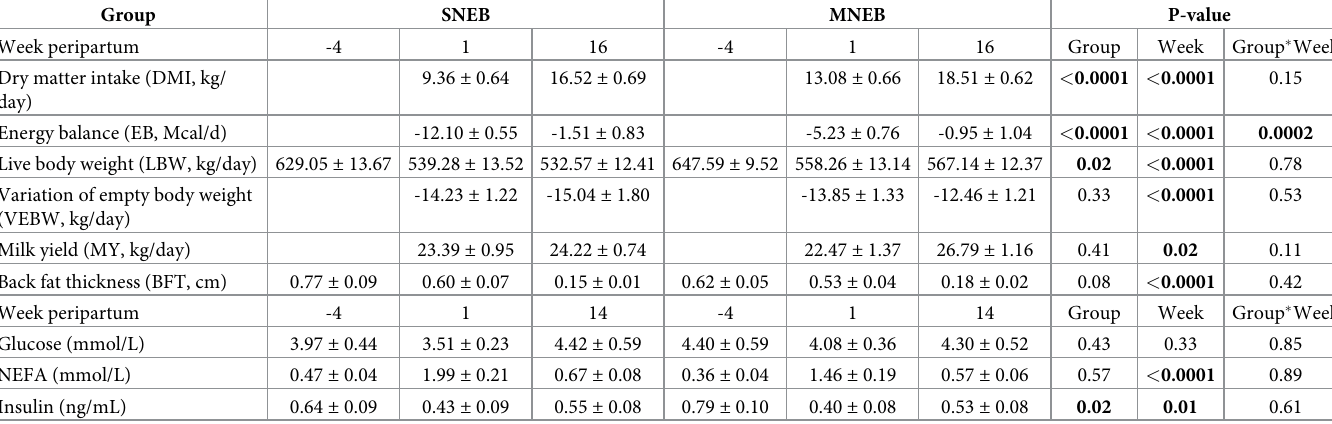
Table 1. Zootechnical and nutritional parameters of cows either with severe (SNEB) or moderate (MNEB) NEB at -4, 1 and 16 weeks peripartum and plasma metab- olites concentration of cows either with SNEB or moderate MNEB NEB at -4, 1 and 14 weeks peripartum.